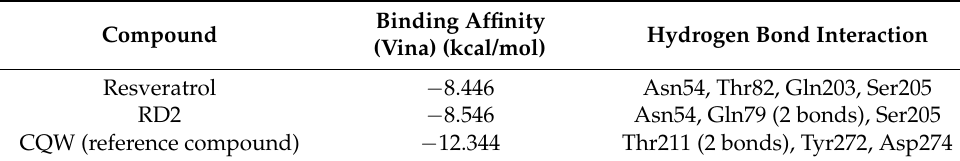
Table 2. The binding affinities of ligands docked with the allosteric site of